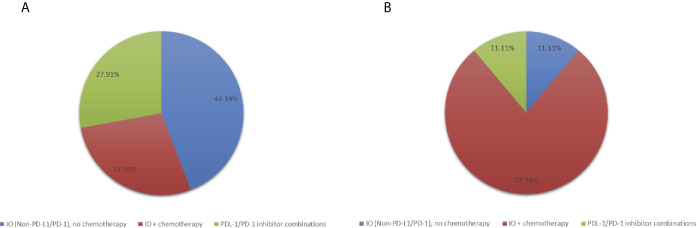
Pie-charts showing (A) Treatment distribution in all patients (N=43) (B) Treatment distribution in patients with PFS ≥ 6 months (N=9).